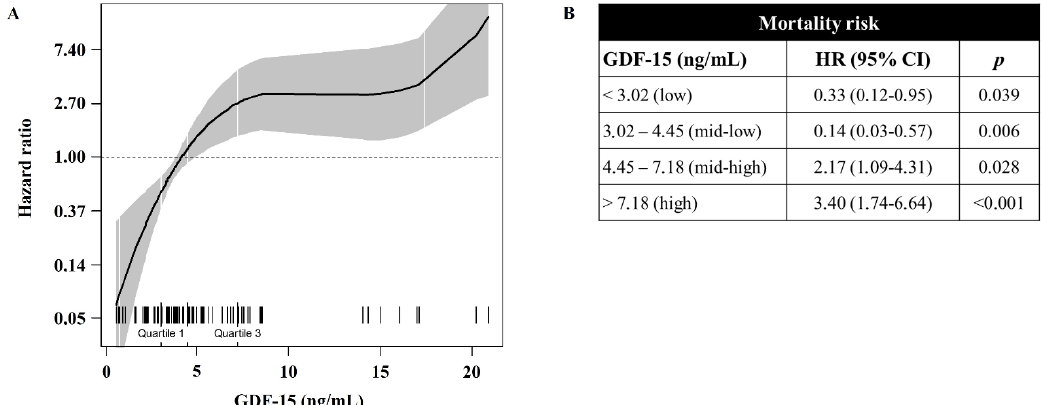
Figure 3. Univariate association between GDF-15 and mortality risk. ( A ) Cubic spline analysis revealing nonlinear association between GDF-15 and mortality risk: the solid line represents the HR according to GDF-15 level, the gray area represents the 95% CI, ticks in the lower part of the figure represent each observation. ( B ) Univariate association between GDF-15 quartiles and mortality risk; each quartile was compared with 3 other quartiles as a whole comparator.